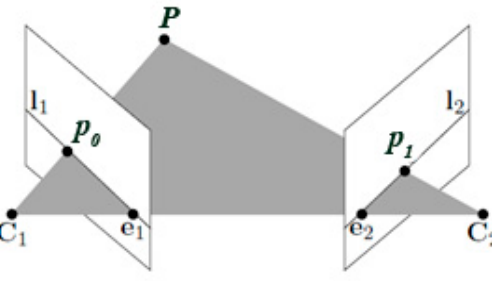
Figure 4. An illustration of epipolar geometry [53,54]. P— a 3D point; p 0 , p 1 —the projections of point P onto the image planes (normalized image coordinates); C 1 , C 2 —the baseline between the two camera centers; e 1 , e 2 —epipolar points; l 1 , l 2 —epipolar lines.